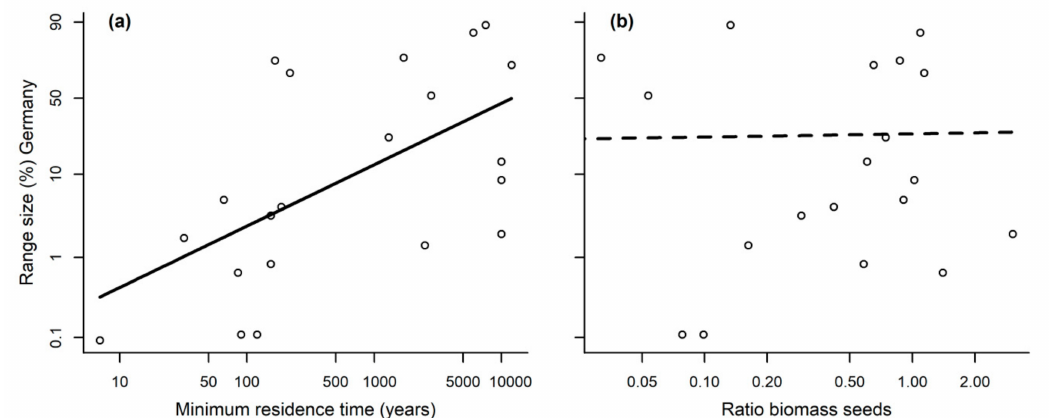
Figure 4. ( a ) Range size depending on minimum residence time; and ( b ) pollinator dependence (i.e., measured as mean biomass seeds without pollinators / mean biomass seeds with pollinators) for the 21 Asteraceae species for which the ratio could be calculated (i.e., biomass seeds with pollinators not zero). All axes are shown on a log-scale. Significant e ff ects (with the other covariate fixed at its mean) shown with a solid line, non-significant e ff ects with a dashed